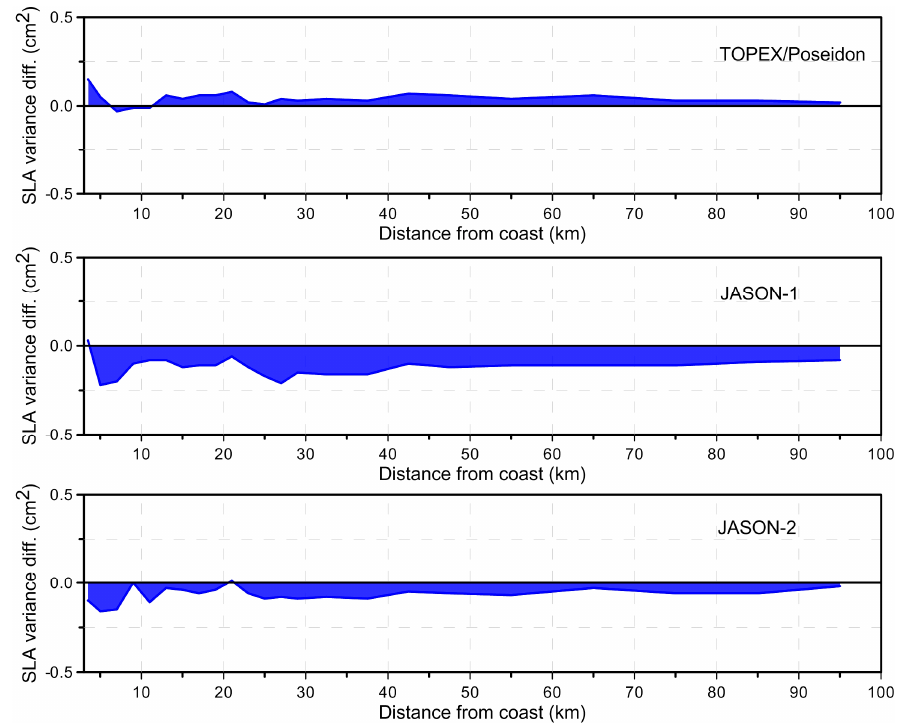
364 ( top-left ); Jason-1 cycles 1 to 259 ( top-right ) and Jason-2 cycles 1 to 280 ( bottom-middle ). Remote Sens. 2017 , 9 , 102